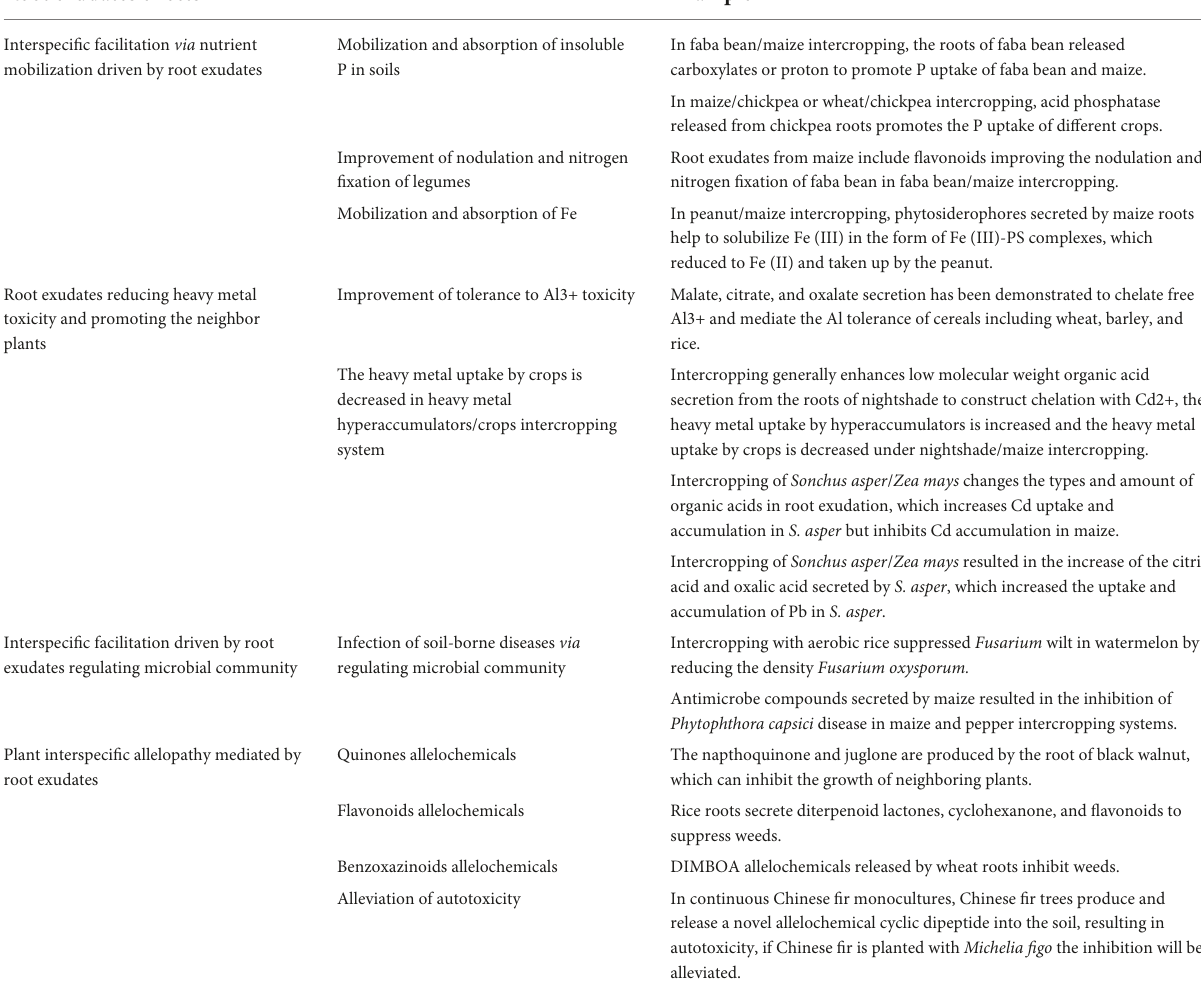
TABLE 1 The general composition of the root